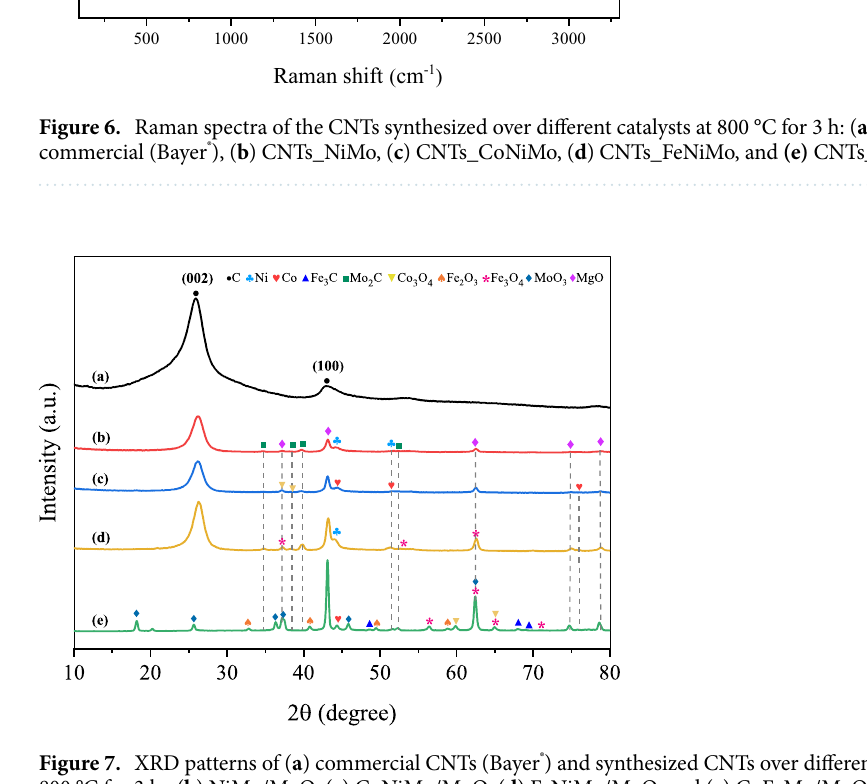
Figure 7. XRD patterns of ( a ) commercial CNTs (Bayer ® ) and synthesized CNTs over different catalysts at 800 °C for 3 h : ( b ) NiMo/MgO, ( c ) CoNiMo/MgO, ( d ) FeNiMo/MgO, and ( e )